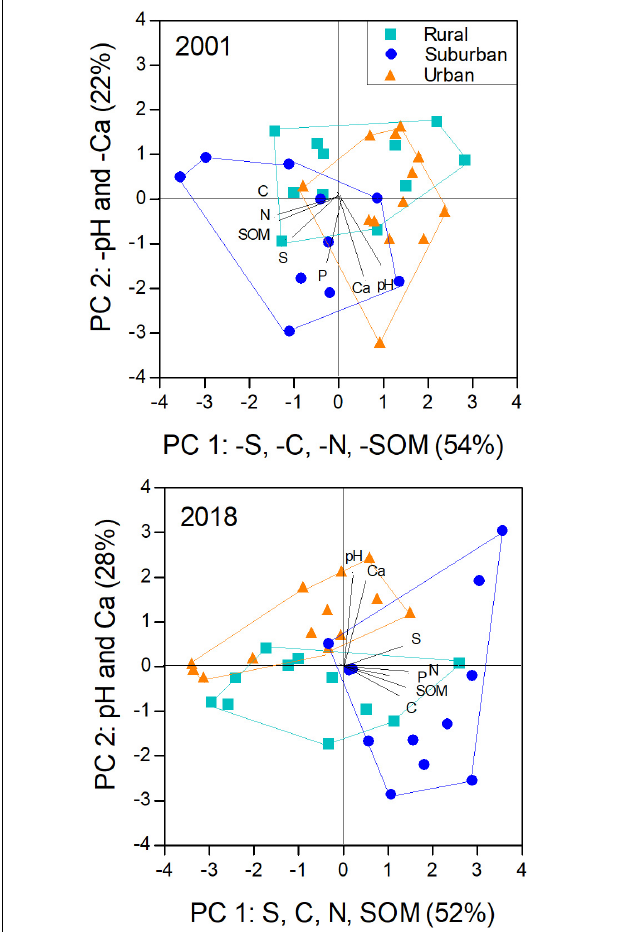
FIGURE 2 | Principal Component Analysis indicates separation of urban, suburban and rural forests plots ( n = 36). The soil variables Ca, P, S, C, N, SOM (soil organic matter), and pH were used from 2001 and 2018.